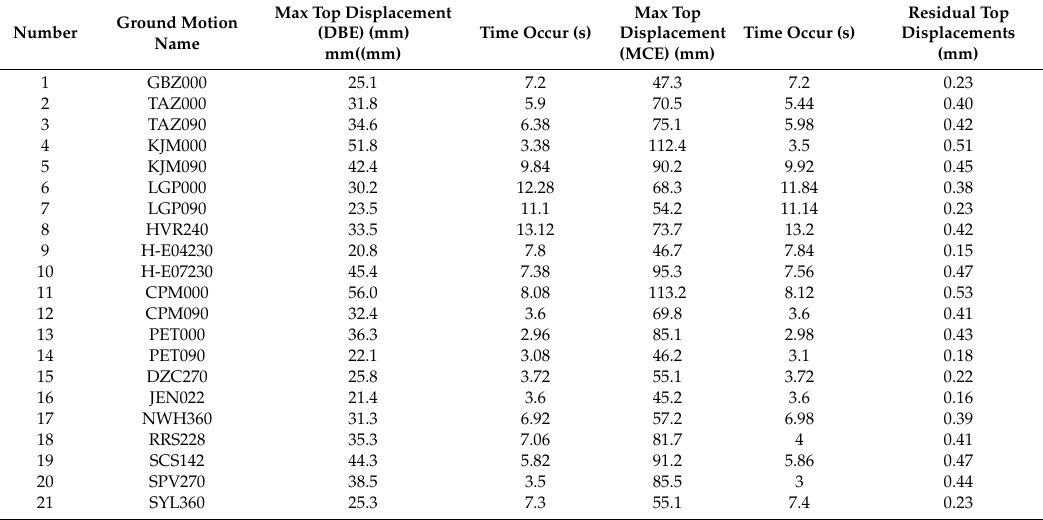
Table 2. Maximum top floor displacements under 21 ground